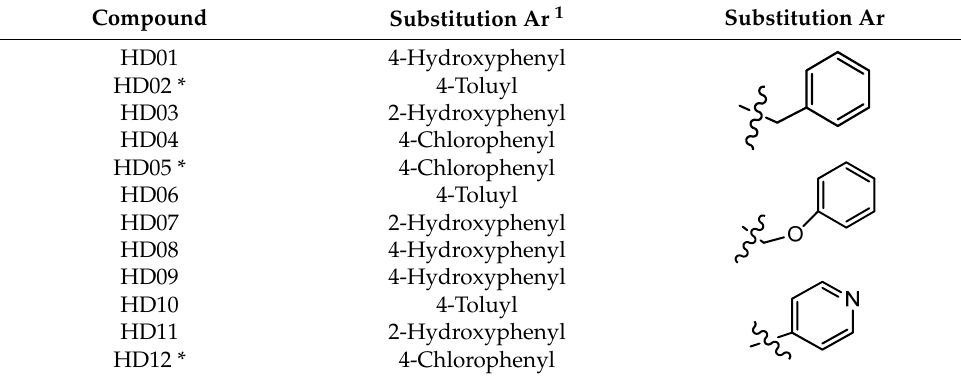
Table 1. Synthesized compounds, HD01–HD12.